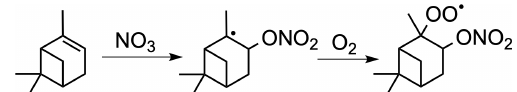
Figure 1. The NO 3 -initiated oxidation of α -pinene produces a ni- trated RO 2 radical ( n RO 2 ). The major isomer is